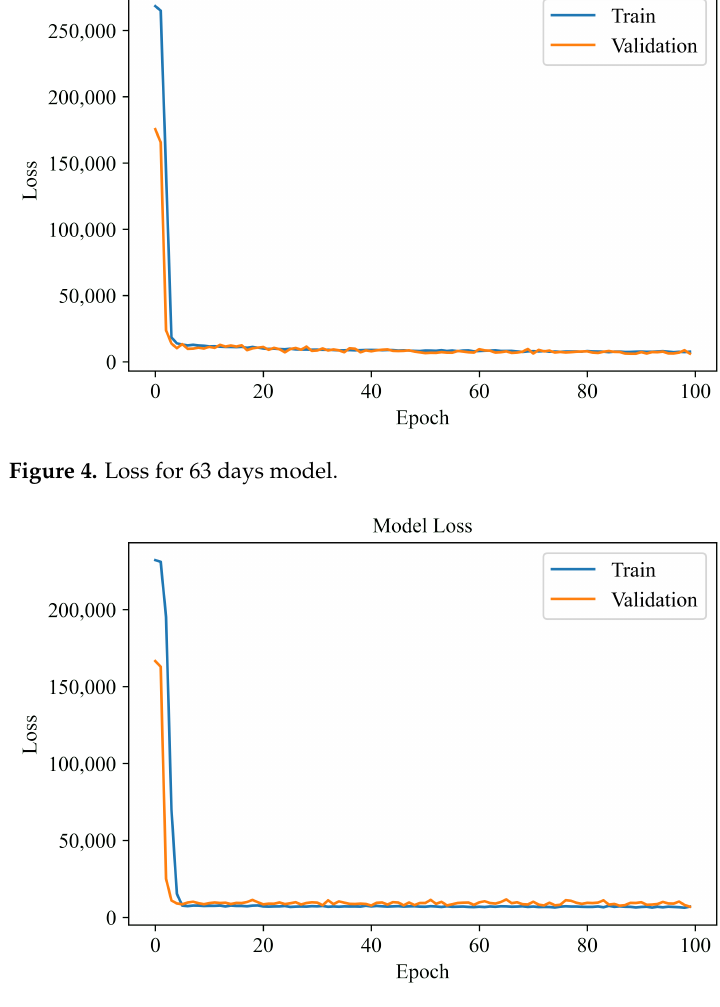
Figure 5. Loss for 126 days